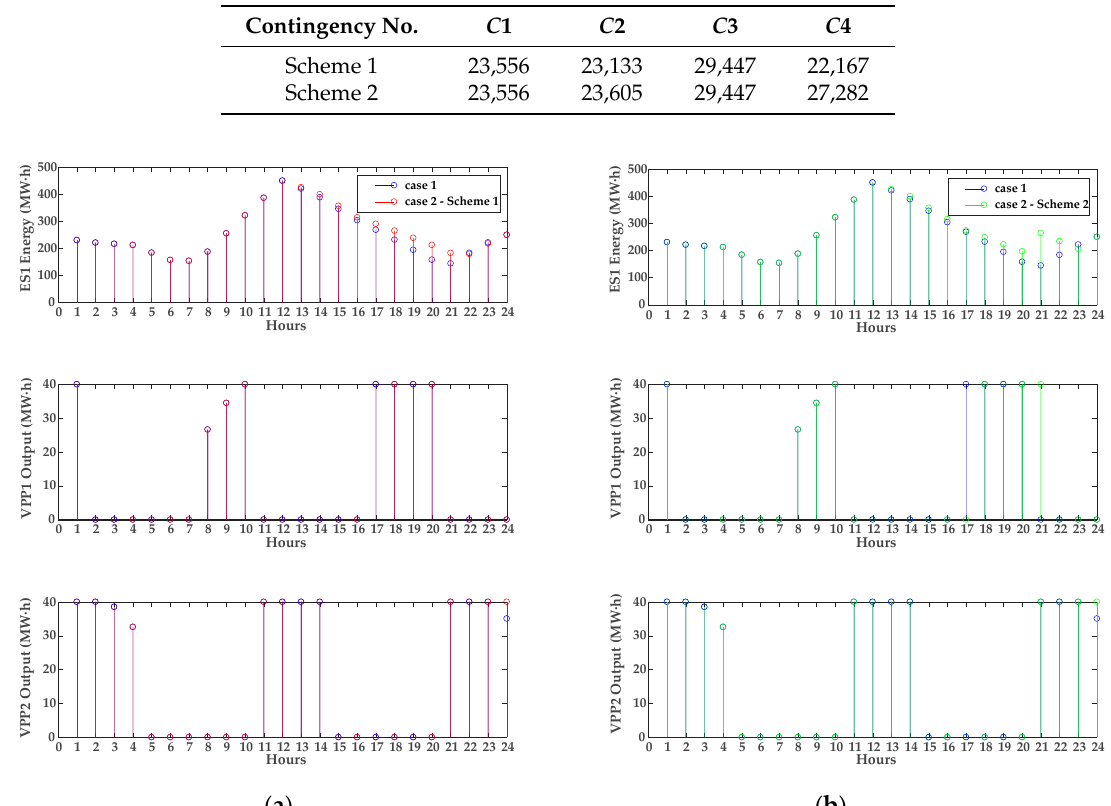
Figure 4. Comparisons of ES 1 stored energy, VPP 1 output, and VPP 2 output under C2 . ( a ) ES 1 stored energy, VPP 1 output, and VPP 2 output in case 1 and case 2 (with scheme 1); ( b ) ES 1 stored energy, VPP 1 output, and VPP 2 output in case 1 and case 2 (with scheme 2).